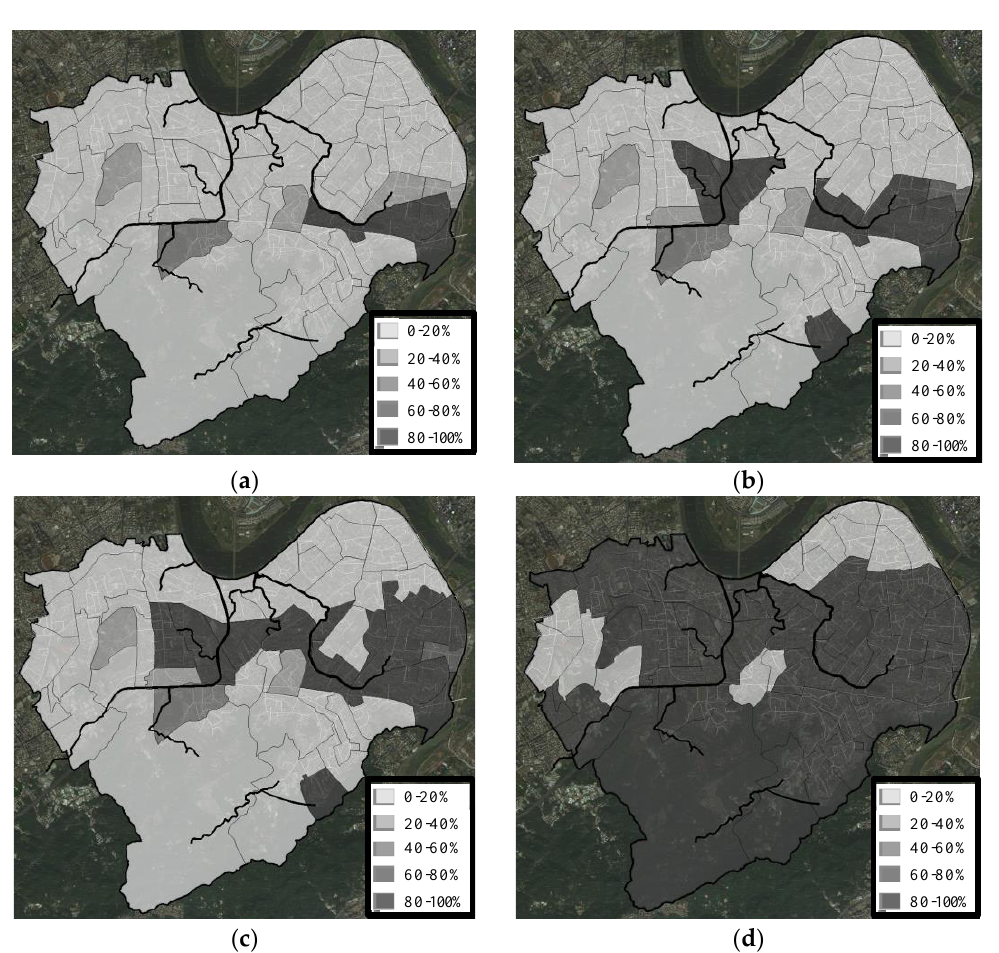
Figure 12. Optimal LID spatial distribution for HFR reduction under different LID costs: ( a ) 30% cost, ( b ) 40% cost, ( c ) 50% cost, and ( d ) 80% cost.